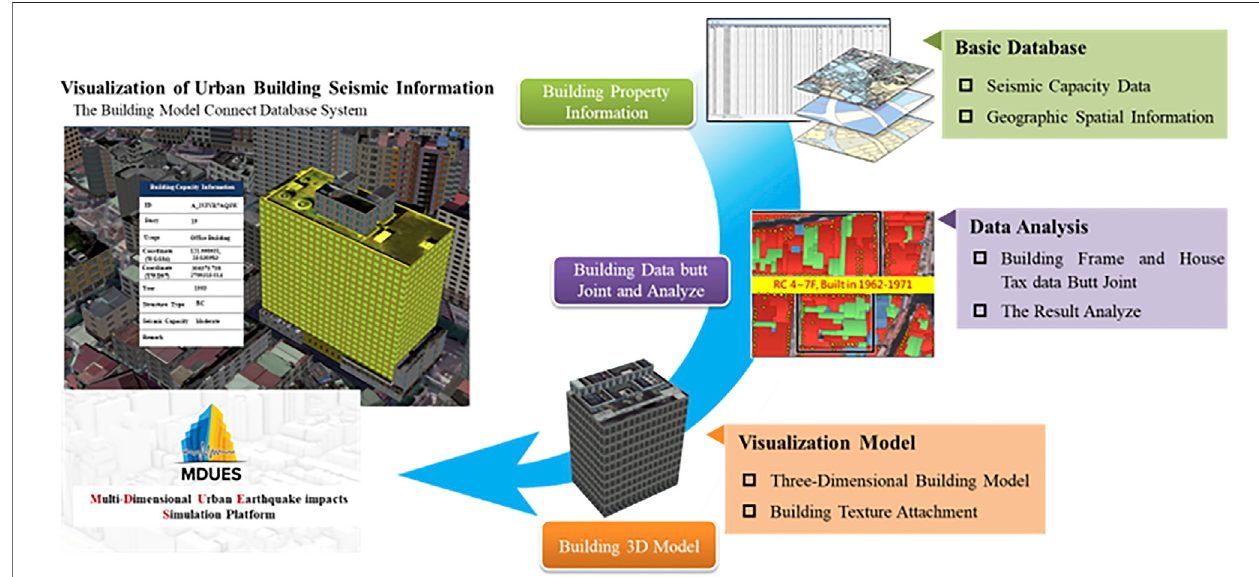
FIGURE 3 | Construction of the 3D database detailing the seismic capacity of urban buildings.